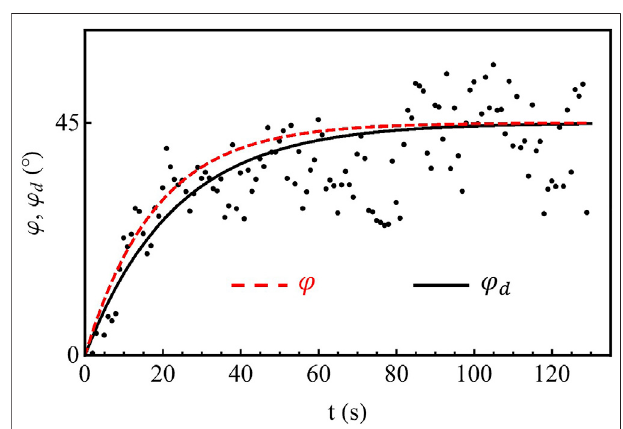
FIGURE3| Theangle φ d betweendroplettrajectoryand the x -axis( fi lled circles),and theangle φ between ^ n and the x- axis (dashedline)asfunctionsof time. The solid line is the least-squares fi tting of the scattered experimental φ d data. U (cid:2) 70V , f (cid:2)